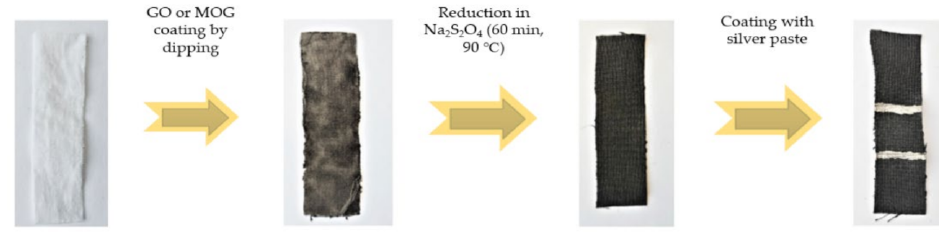
Figure 1. Stages of making samples of